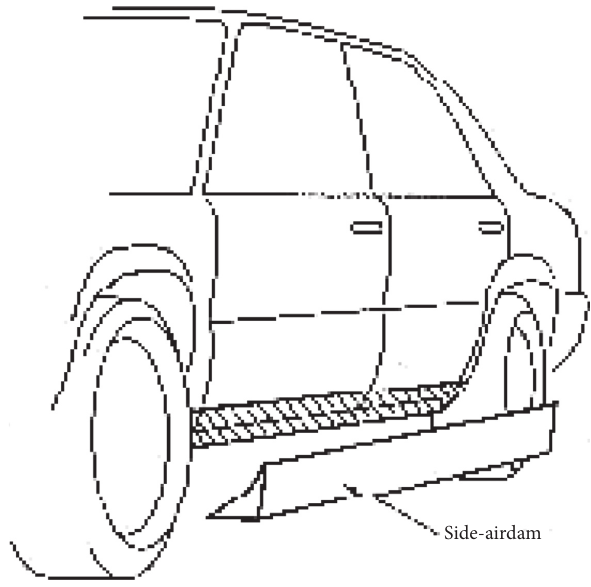
Figure 5: View of the lateral air barrier